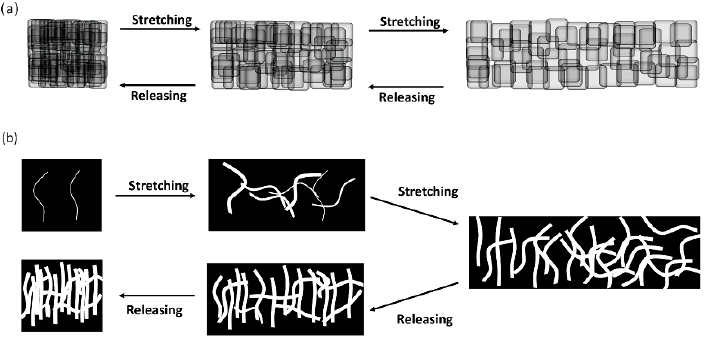
Figure 7. Schematic demonstration of the sensing mechanism of ESD sensing layer ( a ) and drop- coated layer ( b ).